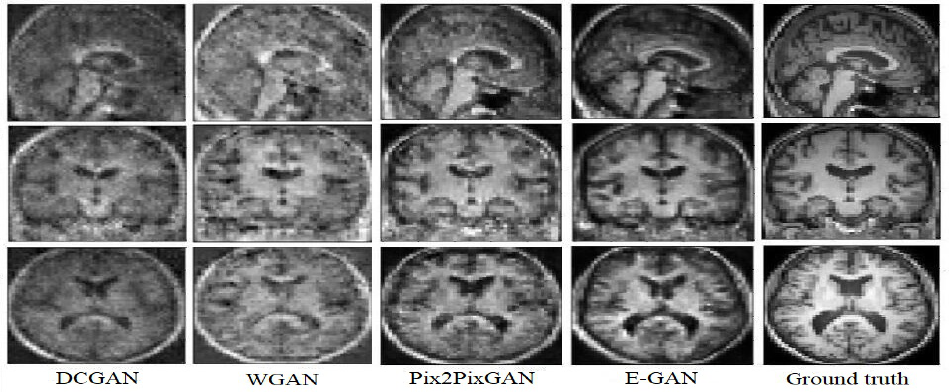
Figure 5. Experimental results for translating PET images to corresponding MRI with 3D DCGAN [35], 3D WGAN [25], 3D Pix2Pix GAN [17], and the proposed